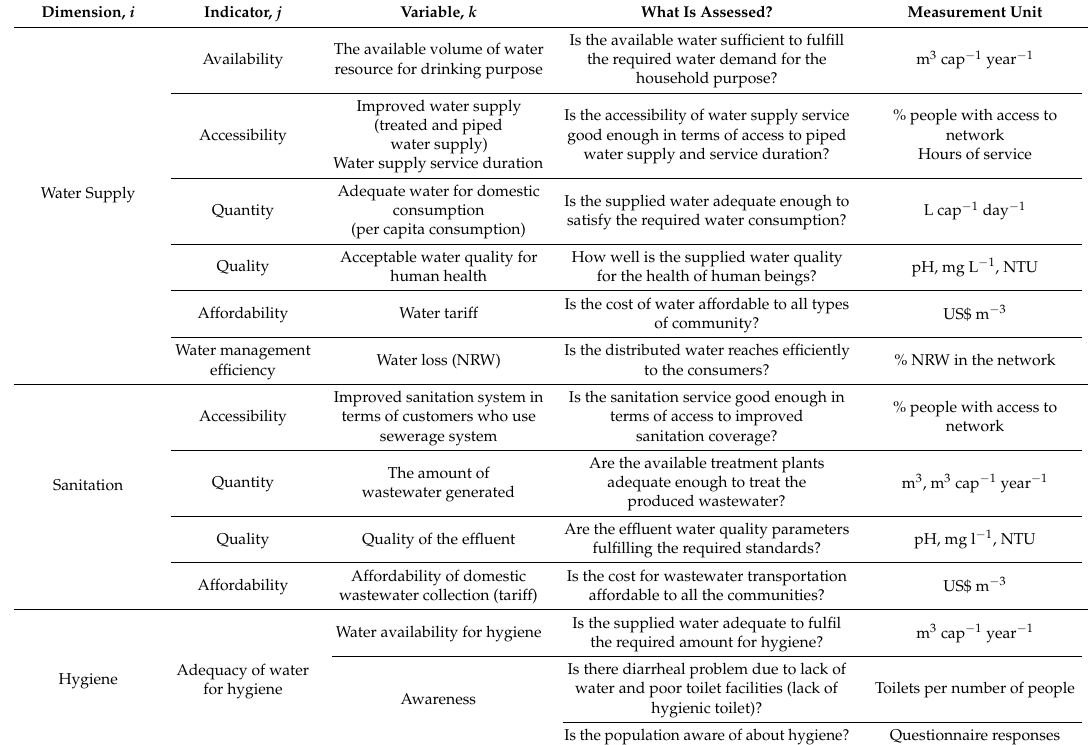
Table 1. Dimensions, indicators, and definition of variables for this